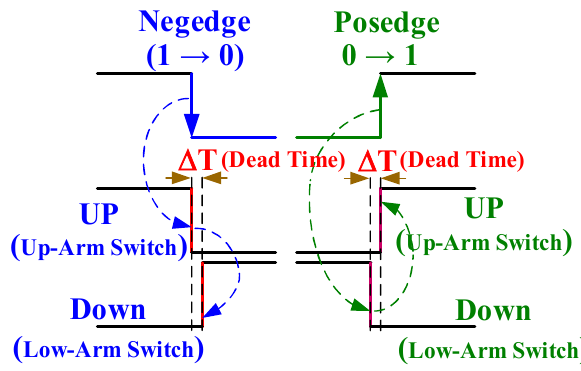
Figure 11. Proposed short-circuit prevention scheme.